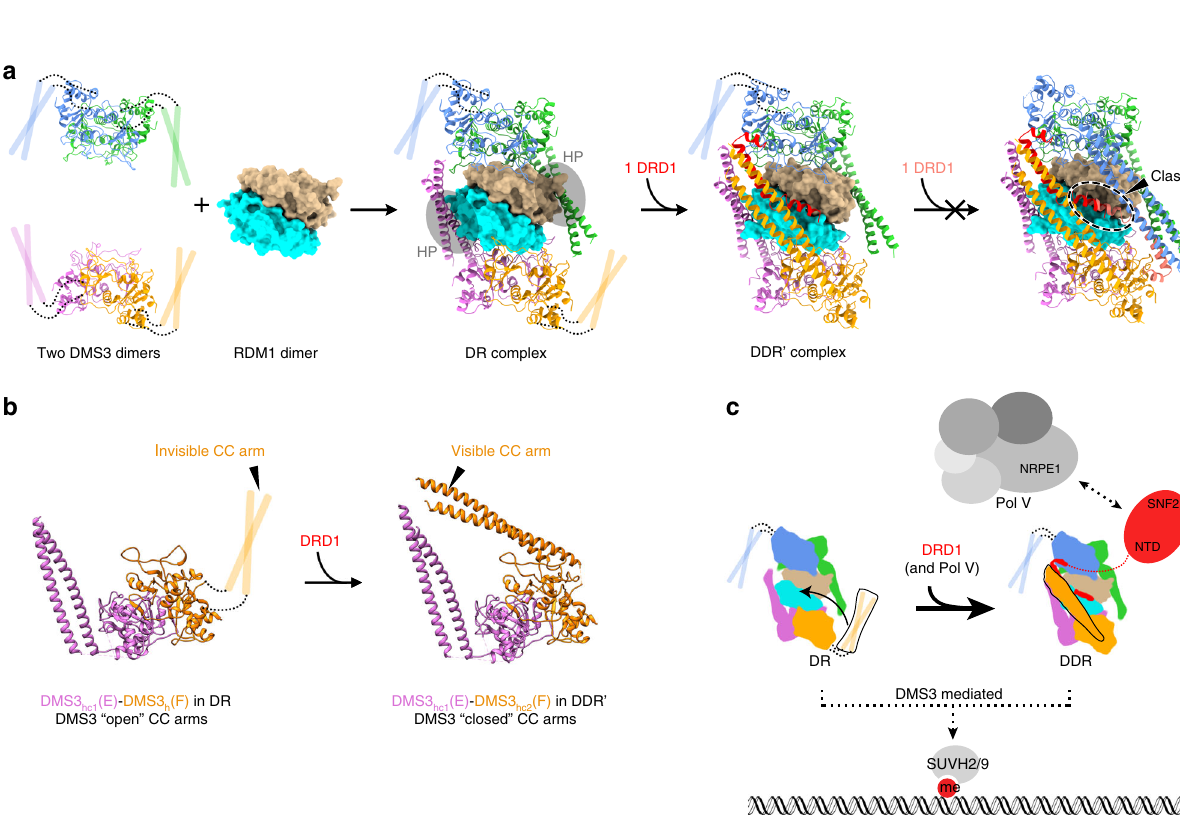
Fig. 4 Possible assembly pathway of the DDR complex that leads to Pol V recruitment. a The assembly characteristics of the DR and DDR ′ complex. The DR complex is a prerequisite for binding of DRD1 peptide 7 but can accommodate only a single DRD1 peptide. Steric clash between the two peptides is expected if another DRD1 peptide binds to the complex. HP, hydrophobic pocket of RDM1. b DRD1 binding converts the DMS3 dimer from “ open ” to “ closed ” state. Chain names are shown inside the parentheses. c Possible mechanisms of chromatin targeting of the DDR complex and Pol V recruitment. The DDR complex is assembled from binding of DRD1 protein to the DR complex. Pol V is then recruited to the DDR complex through interaction with DRD1. However, it is also possible that Pol V is recruited at the same time as DRD1, as a preformed DRD1-Pol V complex. Chromatin targeting could happen during either step and is likely to be mediated, at least, by interaction between DMS3 and methylated DNA binders SUVH2 or